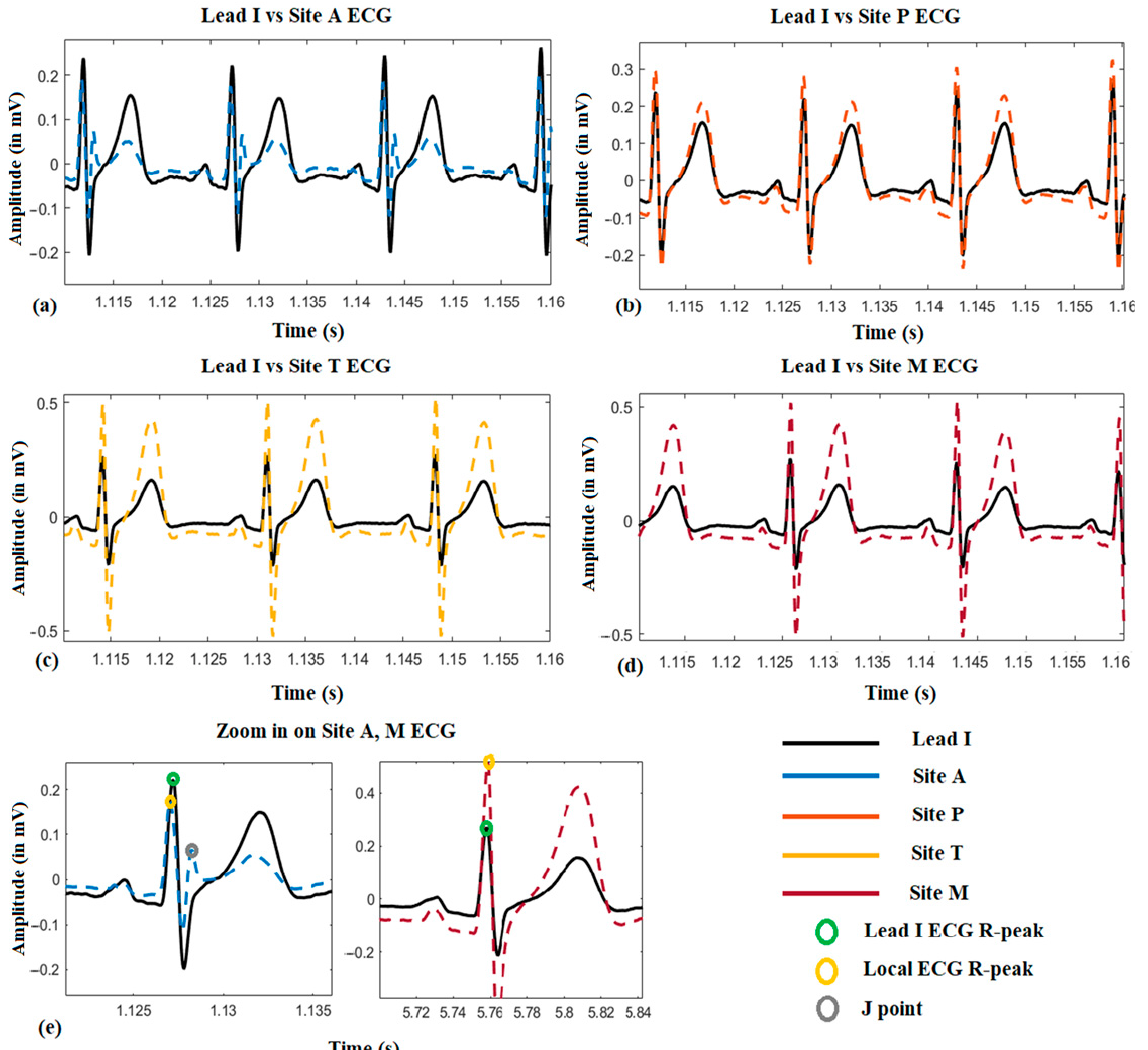
Figure 4 . The local ECG morphological variation compared with reference Lead I ECG.